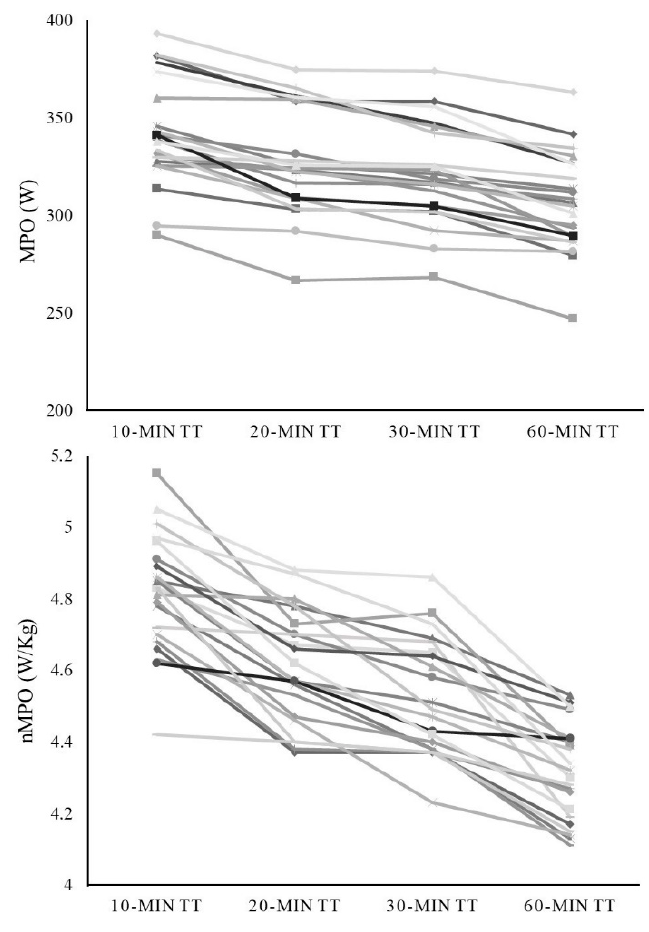
Figure 2. Individual analysis of the power output during running, in absolute (upper panel) and relative values (lower panel) (i.e., 10-min, 20-min, 30-min and 60-min time trials). MPO: mean power output; nMPO: normalized mean power output. Table 3. Level of agreement between power output obtained during different running based-time trials regarding the reference duration (60-min time